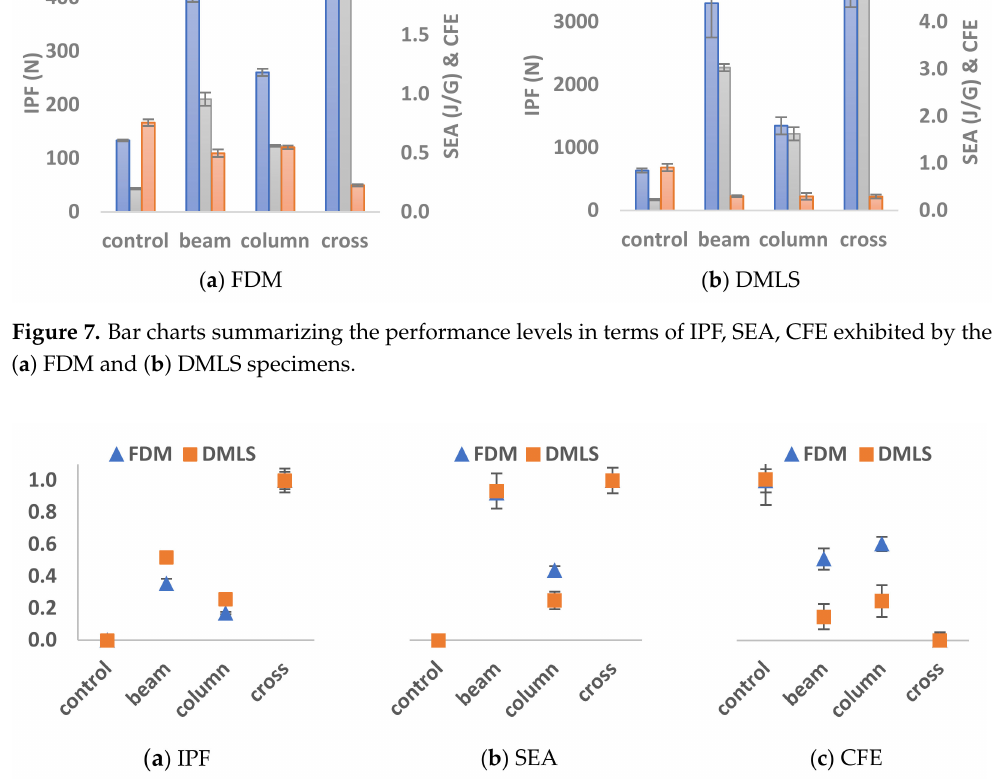
Figure 8. Comparative analysis between FDM and DMLS normalized performance indices: ( a ) IPF, ( b ) SEA, and ( c )